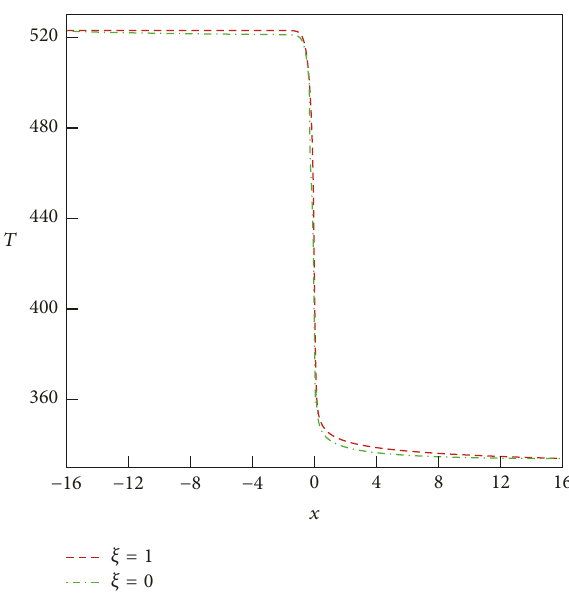
Figure 5: Profiles of temperature with different slip parameters.